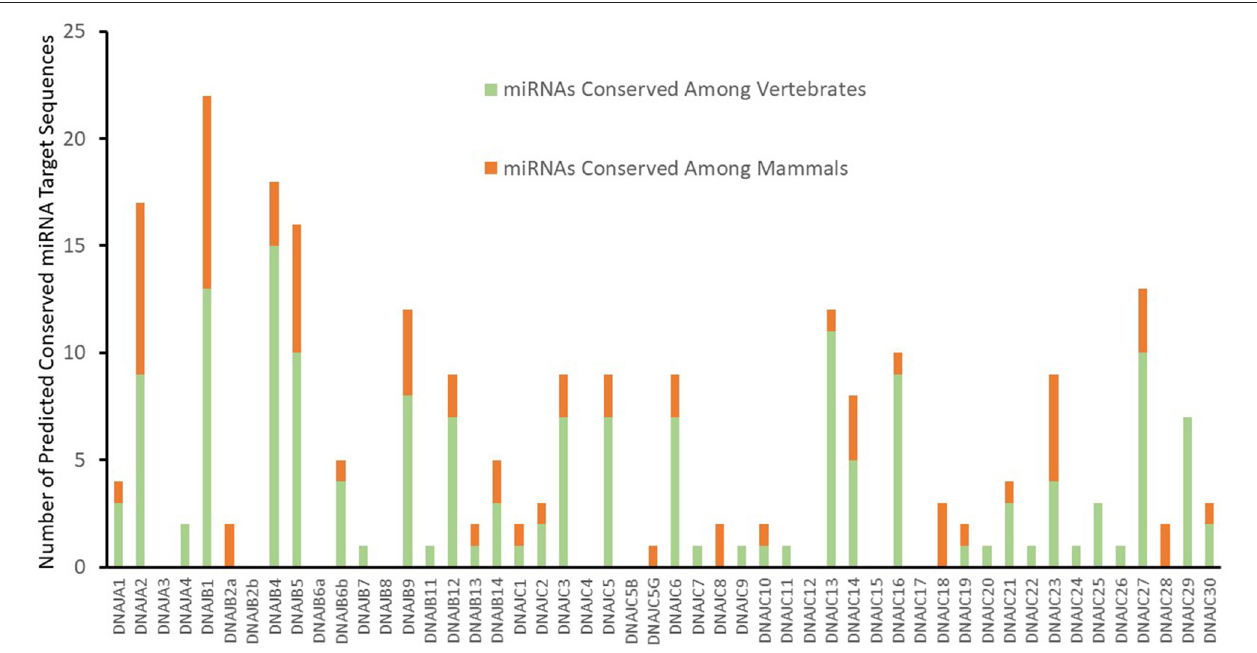
FIGURE 1 | Predicted targeting by conserved miRNA Families. Predicted conserved J-Protein target sites of miRNAs from TargetScan (Agarwal et al., 2015) with a context score of < − 0.1. The number of predicted conserved miRNA targets for each of the J-proteins are indicated. The proportion of predicted targets by miRNAs and miRNA families broadly conserved throughout vertebrates or only within mammals are also